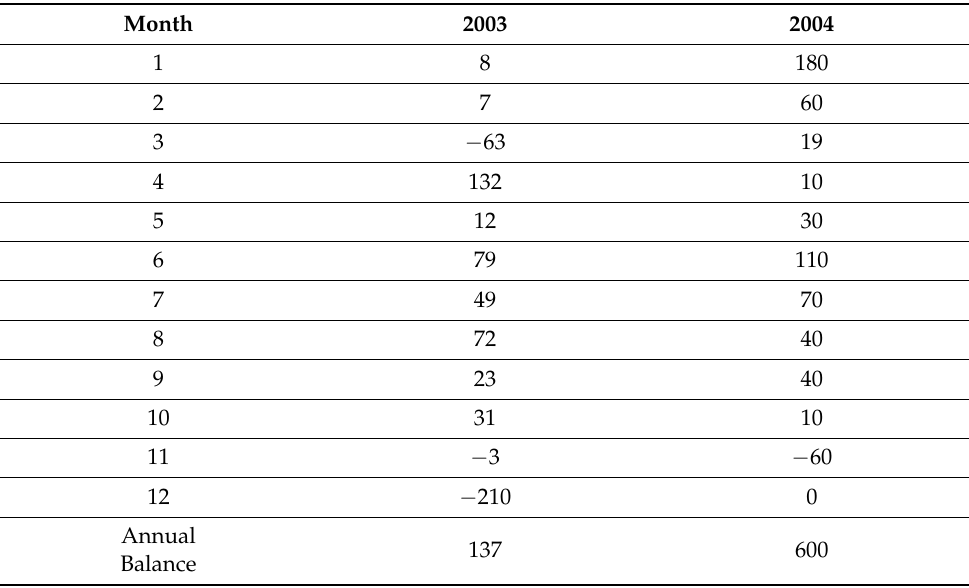
Table 3. Monthly mass balance (kg/month) (input minus output) of TP in Lake Agmon-Hula in 2003 and 2004 (positive value = retained; negative value = deficit). The input sources are peat soil drainage through Canal Z, Canal East, and the reconstructed Jordan Branch